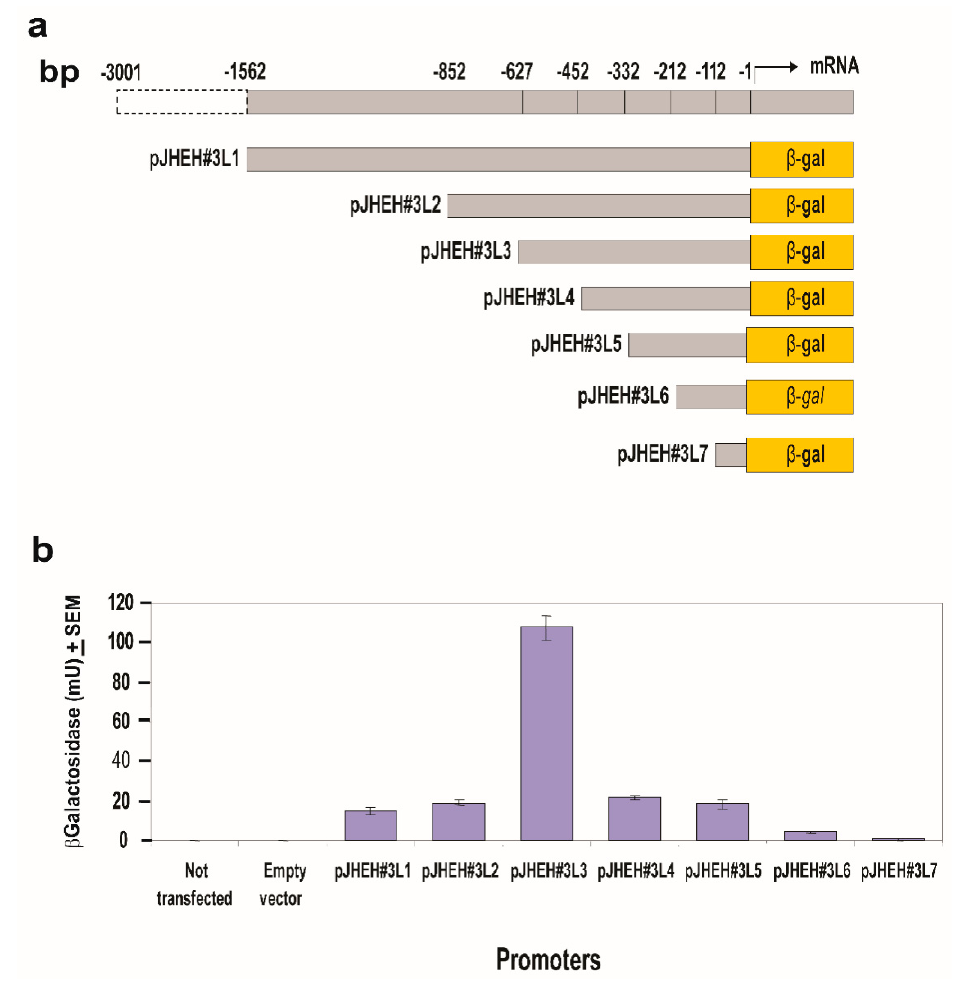
Figure 7. Testing jheh 3 different promoter sequence lengths ( a ) for transcriptional activity ( b ) by cloning them into plasmid pCaSpeR-AUG- β gal, transfecting D.Mel2 cells with the recombinant plasmid and assaying 2 × 10 5 cells for β -galactosidase activity expressed in milliunits (mU). Controls were D.Mel2 cells that were not transfected or transfected with empty plasmid.